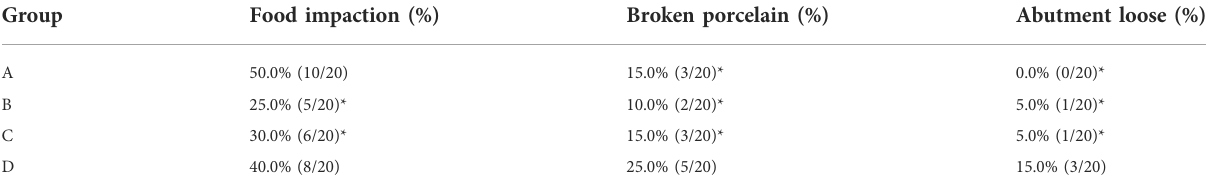
TABLE 5 Statistics of common mechanical complications within 3 years of weight-bearing in groups A – D. Group Food impaction (%) Broken porcelain